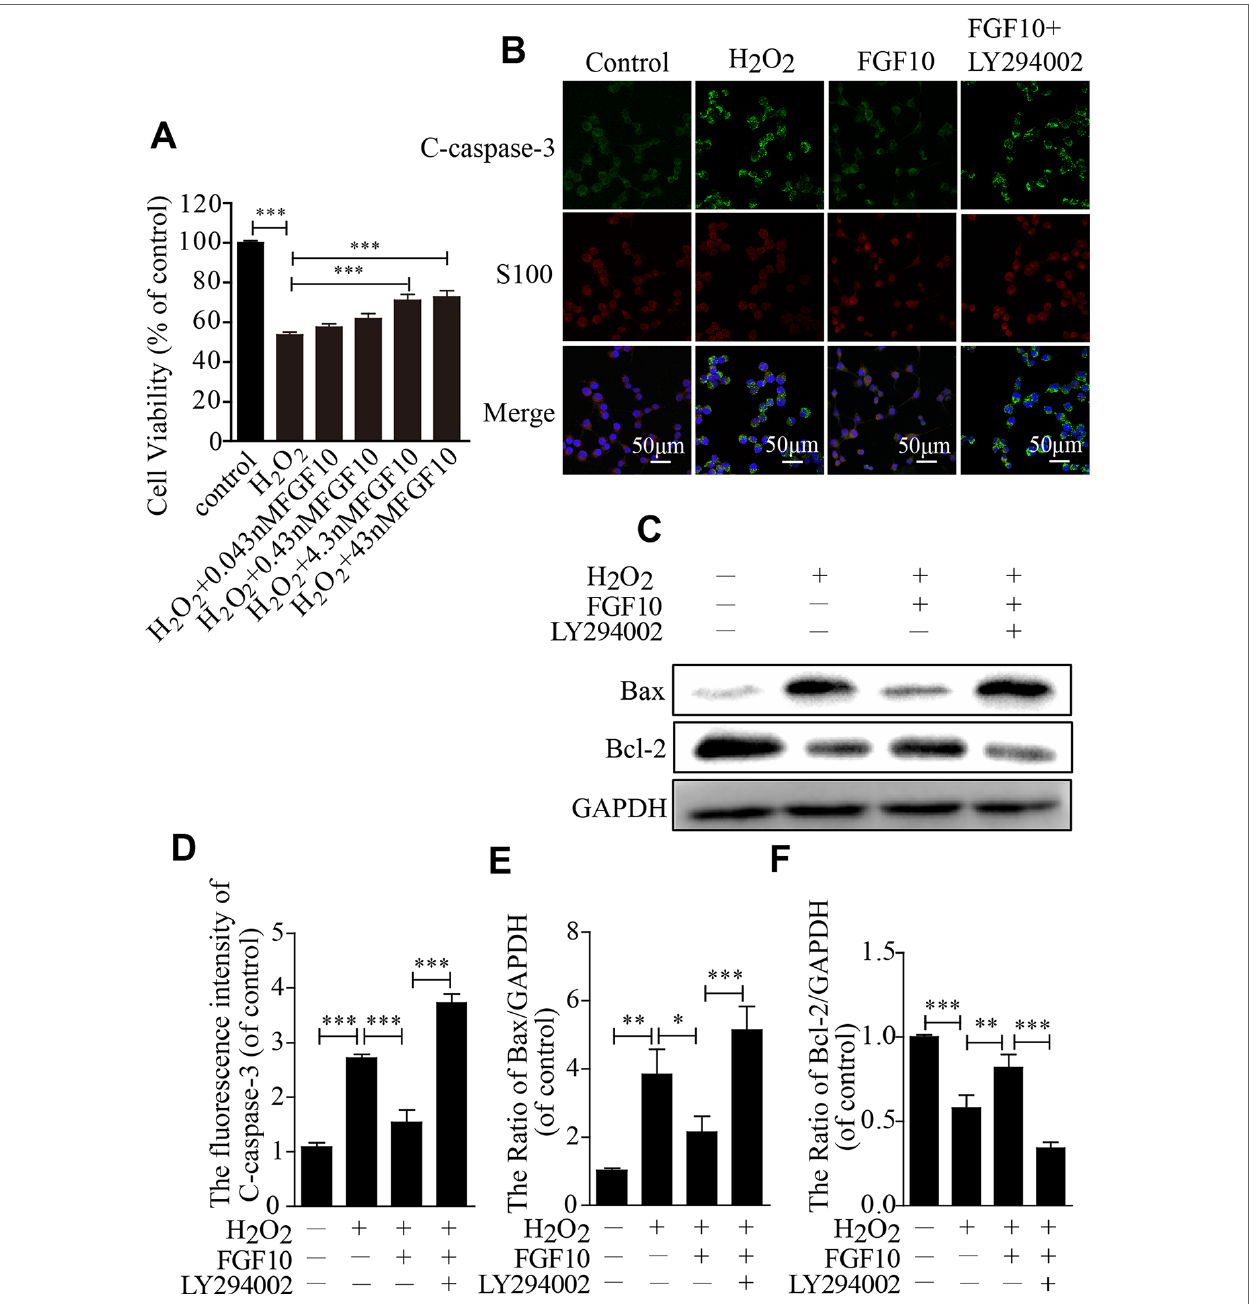
FIGURE 6 | Fibroblast growth factor 10 (FGF10) inhibits Schwann cell (SC) apoptosis in vitro . (A) H 2 O 2 -induced cell survival was evaluated by the CCK-8 assay. (B) Immunofluorescence staining results of cleaved-caspase-3 (green) and S100 (red) in each group. Scale bar = 50 μm. (C) The protein levels of Bax and Bcl-2 were detected by western blotting. (D) Statistical analysis of the cleaved-caspase-3 intensity in each group. (E , F) The quantification of Bax and Bcl-2 expression was assessed via a gel imaging system. All of these data represent the means ± SEM, n = 3. Control group vs H 2 O 2 group: ** P < 0.01, *** P < 0.001. FGF10 group vs H 2 O 2 group: * P < 0.05, ** P < 0.01, *** P < 0.001. FGF10 group vs H 2 O 2 +LY294002 group: *** P <